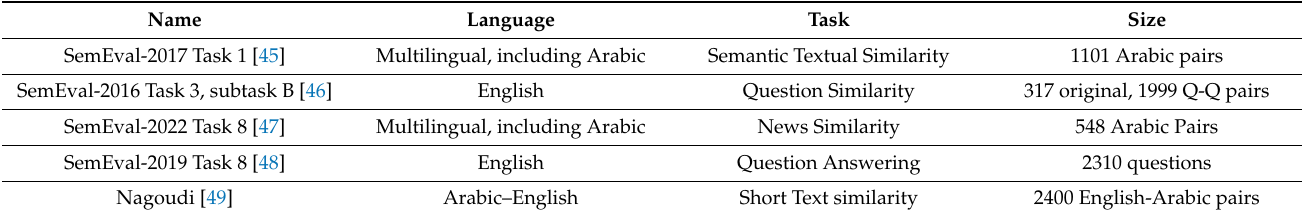
Table 3. Sizes of datasets of similar experiments.